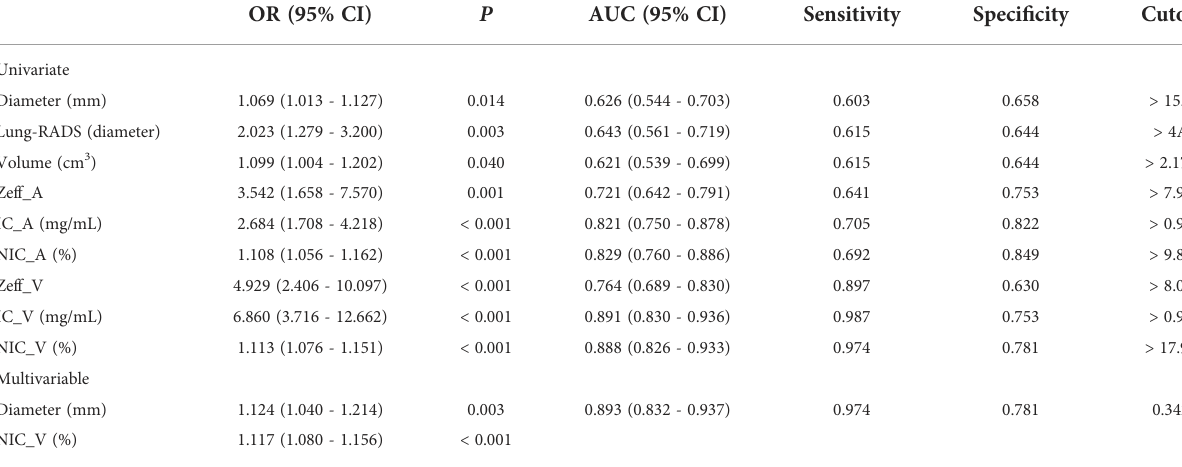
TABLE 2 Univariate and multivariable logistic regression analysis for predictive